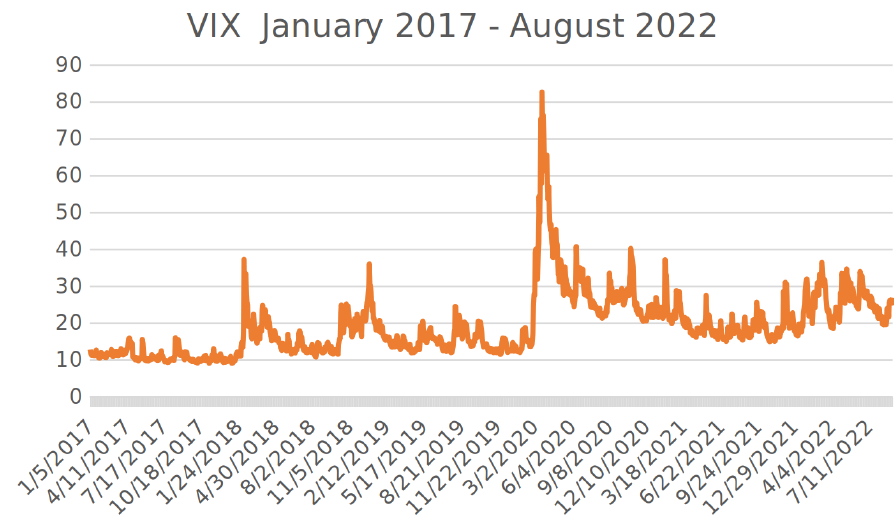
Figure 5. Chart of the VIX from January 2017 until August 2022.